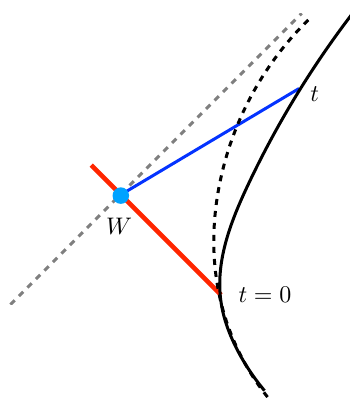
Figure 4 . The distance from the operator to the boundary increases as time